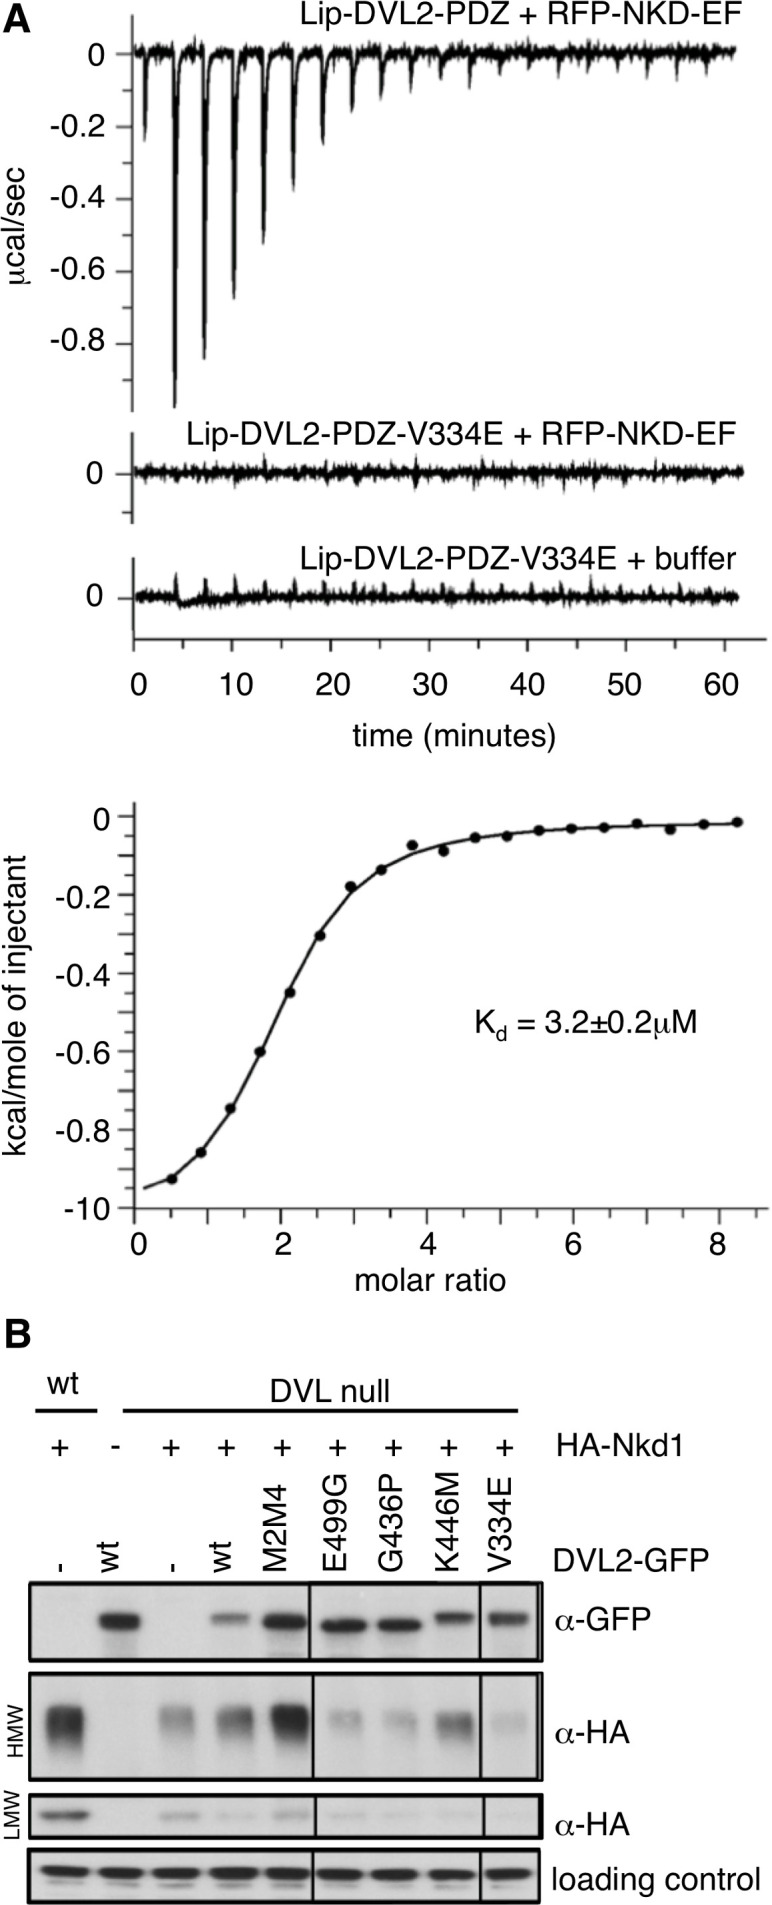
Binding of the NKD1 EF-hand to the DVL2 PDZ cleft.(A) ITC profiles for NKD1 EF-hand binding to the wt DVL2 PDZ domain or its V334E cleft mutant; Kd value obtained with wt DVL2 PDZ domain. (B) Western blots monitoring the formation of Nkd1 HisC aggregates dependent on complementation of DVL null cells by re-expression of wt or mutant DVL2 (see also main Figure 4D).